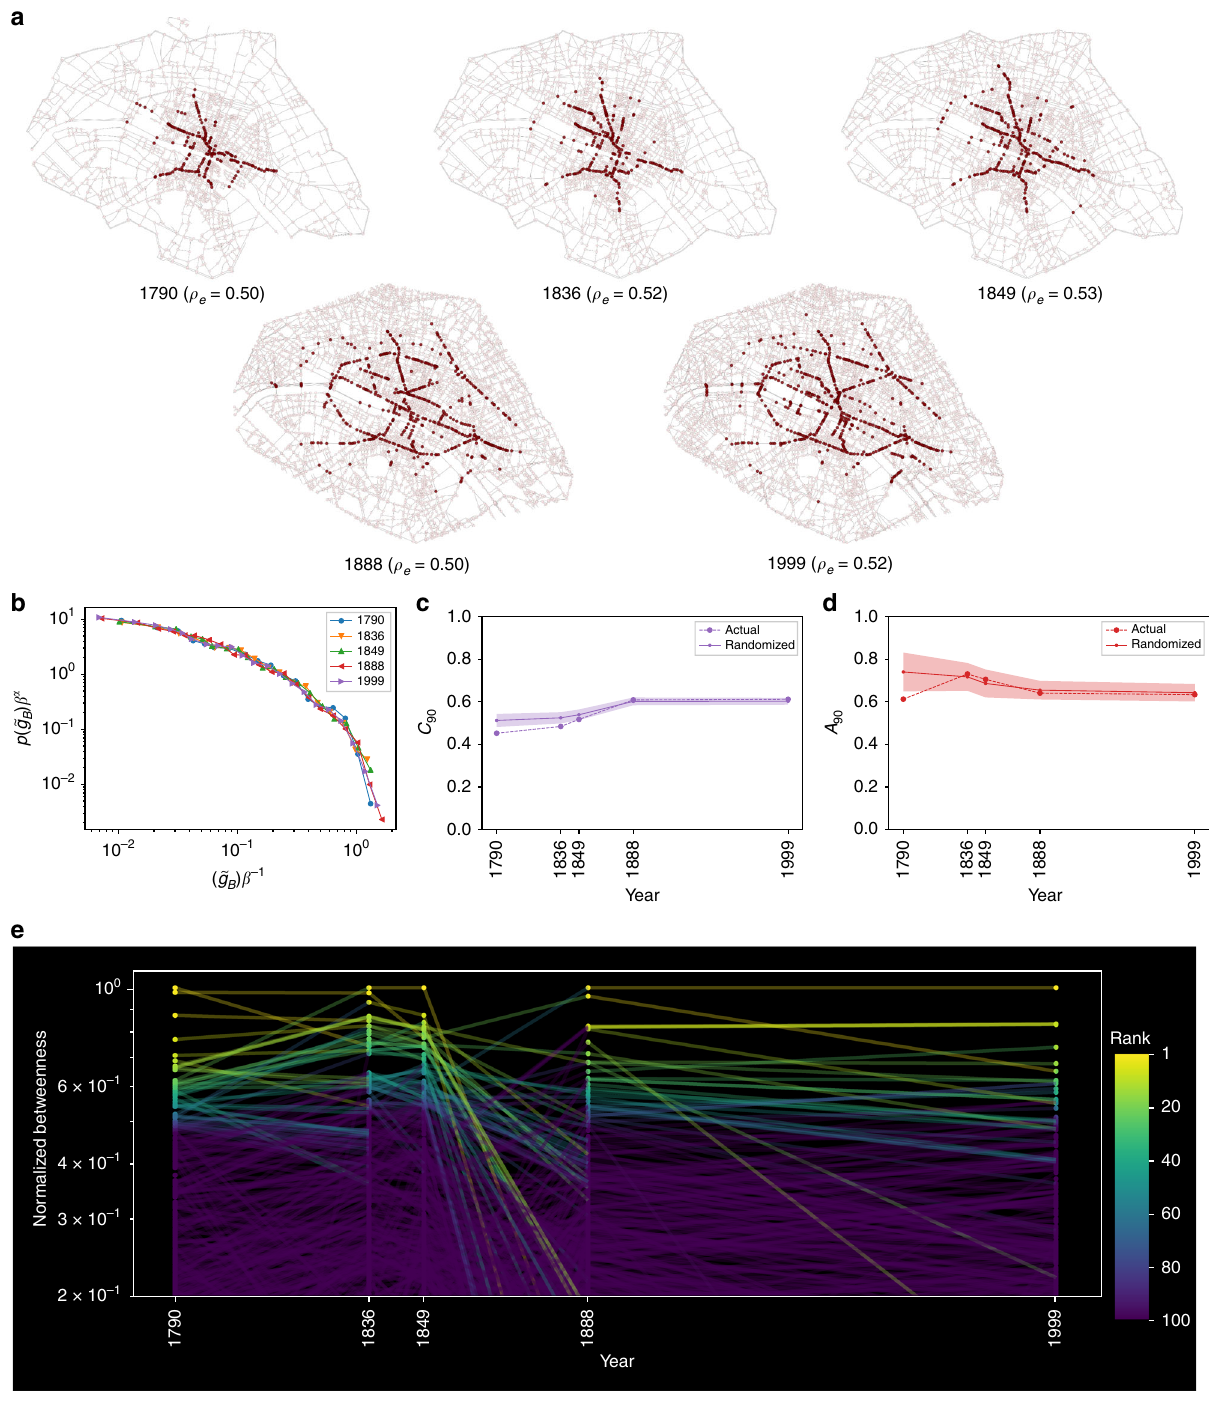
Fig. 6 Evolution of central Paris from 1790 to 1999. a Five snapshots of a portion of central Paris spanning two hundred years. Colored in red are the nodes corresponding to the 90th percentile in terms of their BC. b The rescaled BC distributions (using the same method as in Fig. 2c) for all fi ve networks showing that they are identical ( α = 1). c The clustering and d anisotropy metrics for the nodes above the 90th percentile. Also shown are the corresponding metrics for hundred realizations of randomized versions of the networks according to the procedure used in Fig. 3. e Temporal evolution of the BC of individual nodes that are present in all fi ve networks. Points are colored according to rank based on BC and lines drawn with reduced opacity for improved “ decongesting ” spatial transition from a radial to a circular the same periods. Furthermore, as indicated by the spatial layout pattern-after which once again the high BC nodes are relatively of these “ new ” high BC nodes, they continue to be relatively close stable till 1999. It is important to note that the load is simply to the center (few or none are near the periphery), a pattern that redistributed to a different part of the network, as can be seen by is consistent with what one would expect to fi nd for the the transition of the middle-ranked nodes to the top positions in corresponding random graphs.